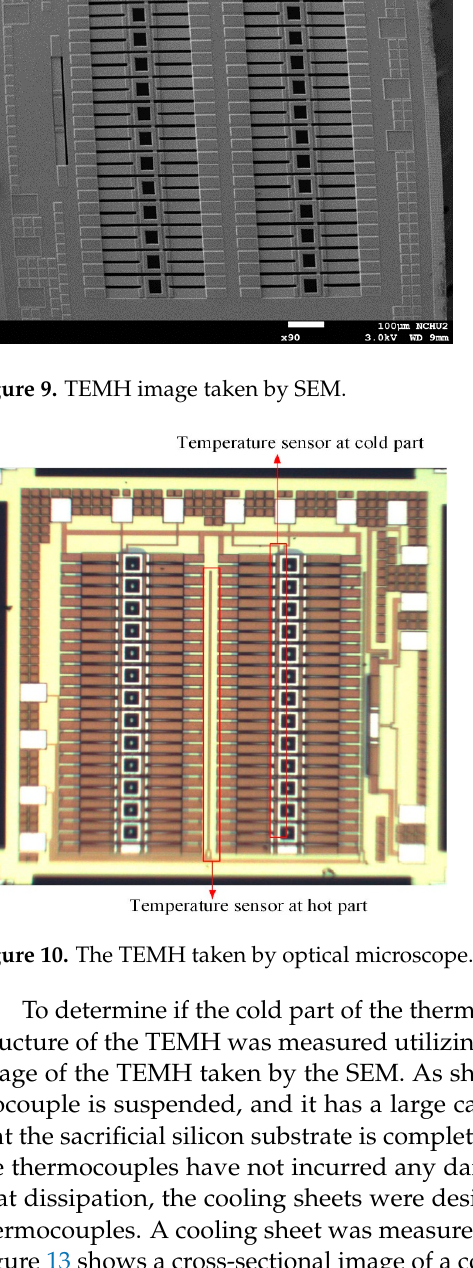
Figure 8. Cross section of the TEMH after etching of the silicon substrate.